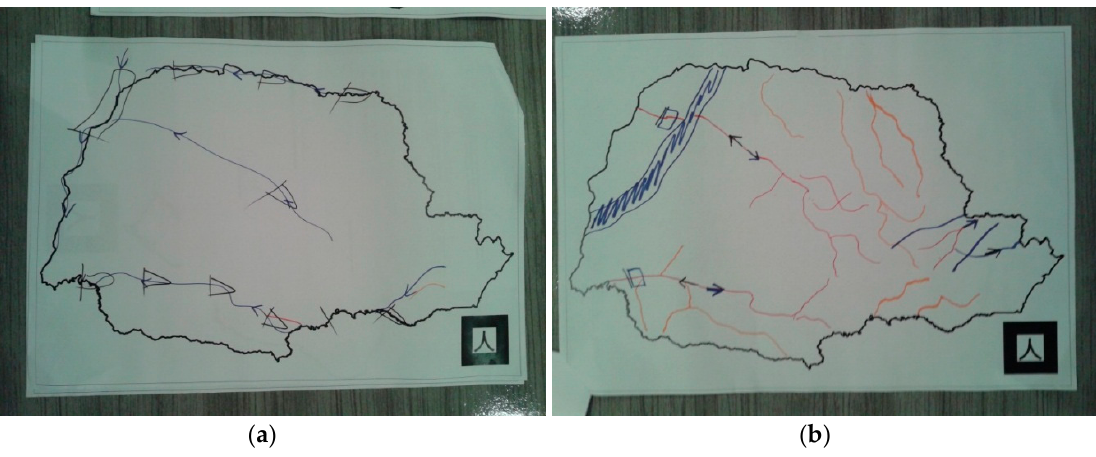
Figure 4. Comparison of the maps resulting from Steps 2 and 3. ( a ) Expert; ( b ) Non-expert. (Developed by the authors).